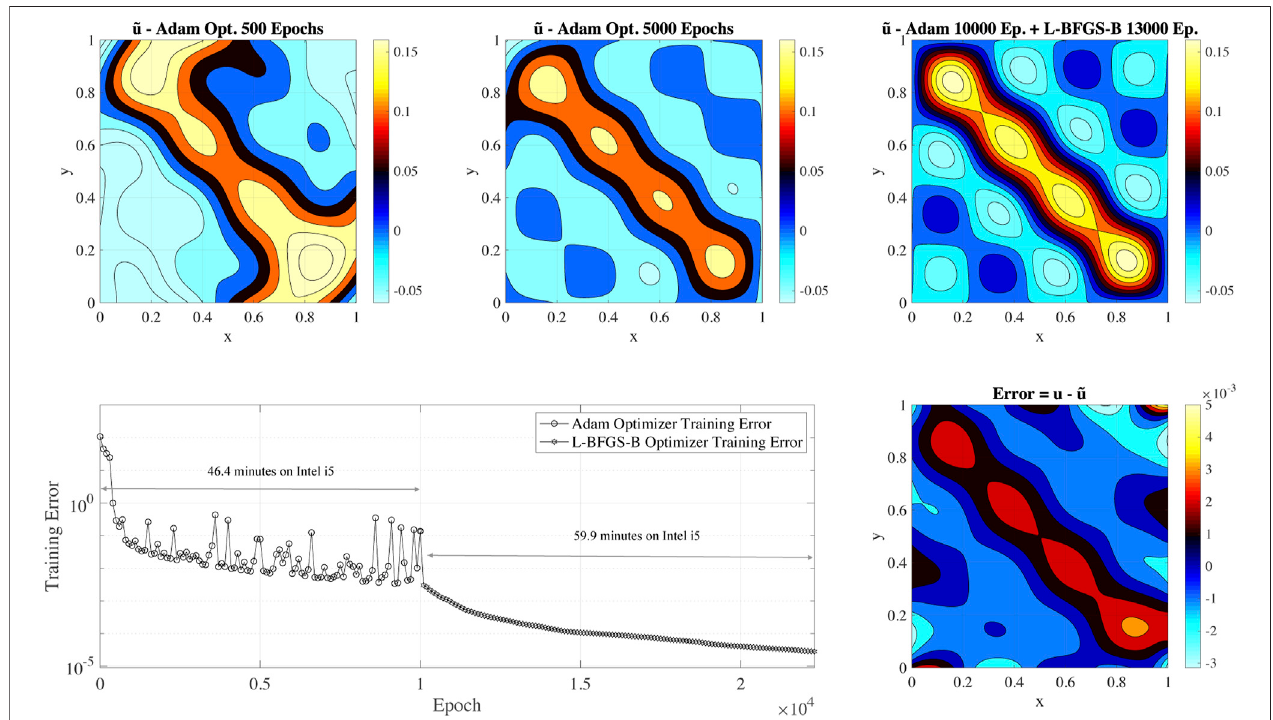
FIGURE 2 | The top panels show the solution of the Poisson equation at different epochs using a PINN. The bottom panel shows the training error for an initial training withAdam ’ s optimizer (10,000 epochs), followed byL-BFGS-B (13,000 epochs). The plotalso includes thetotal time for training the PINN on adual-core Intel i5 processor. The right bottom subplot presents the error of the fi nal solution compared to the exact